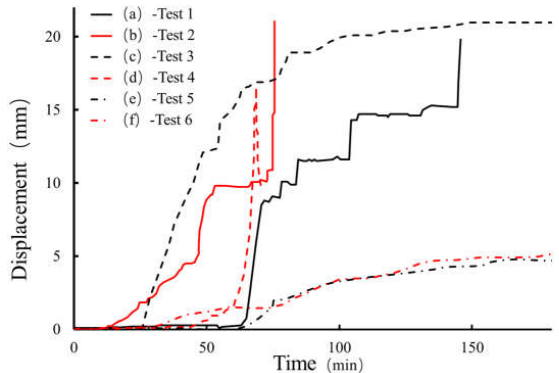
Figure 11. Curves of slope displacement.